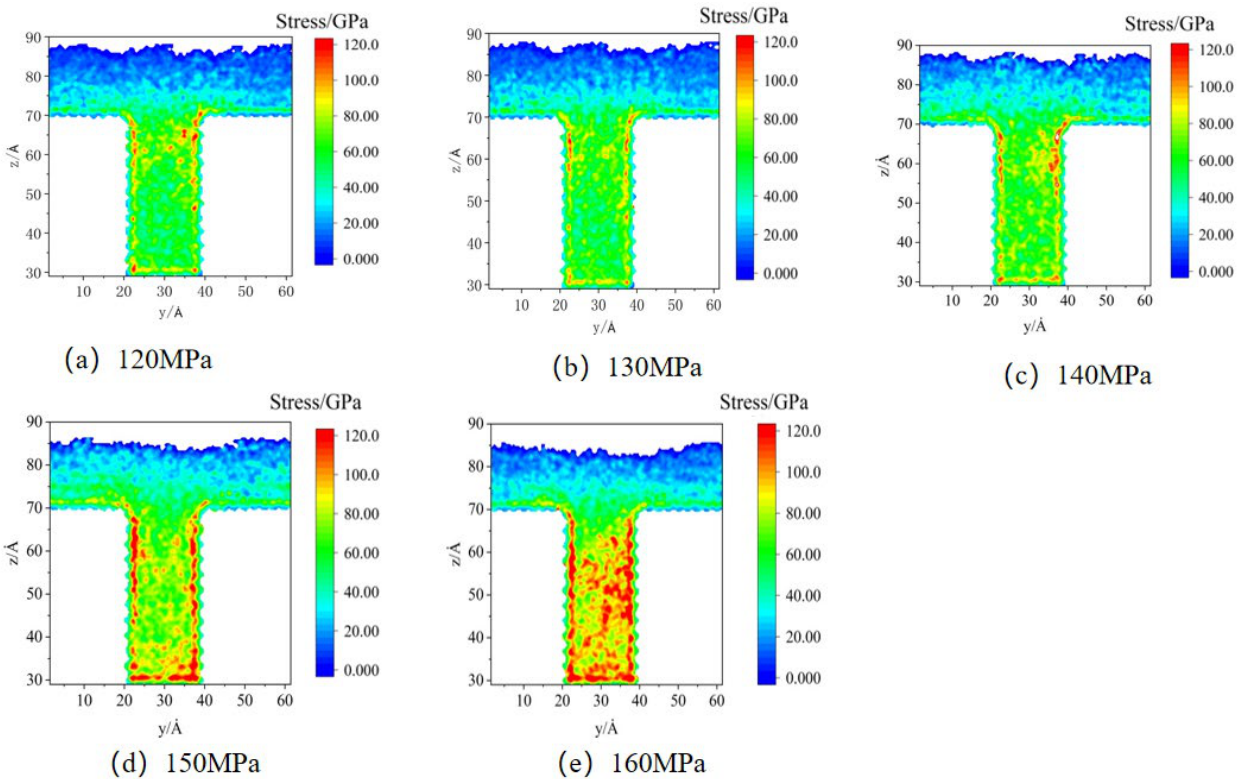
Figure 15. Stress distributions at different packing pressures in MD simulation.